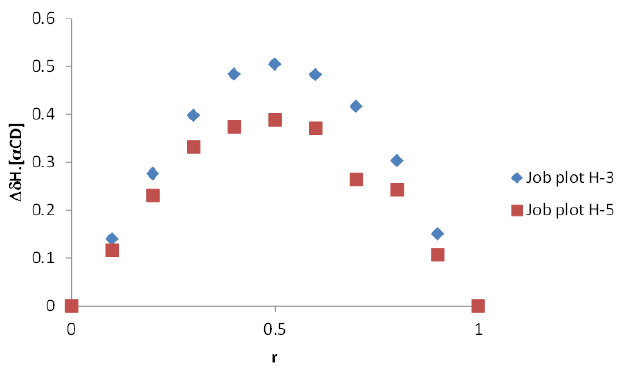
Figure 8. Continuous variation plot (Job Plot) for H3 and H5 protons of α -CD (600 MHZ, D 2 O, 300 K).